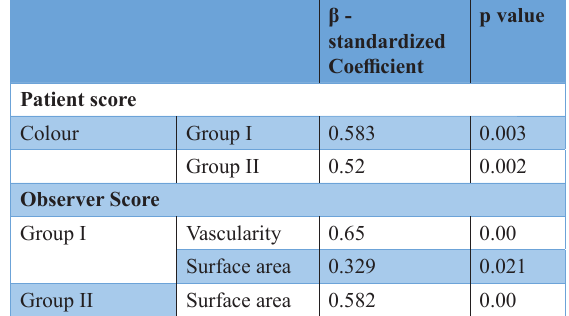
Table 3. Regression analysis between Patient's (PSAS) items and Patient Overall opinion, and Observers' (OSAS) items and Observer Overall Opinion